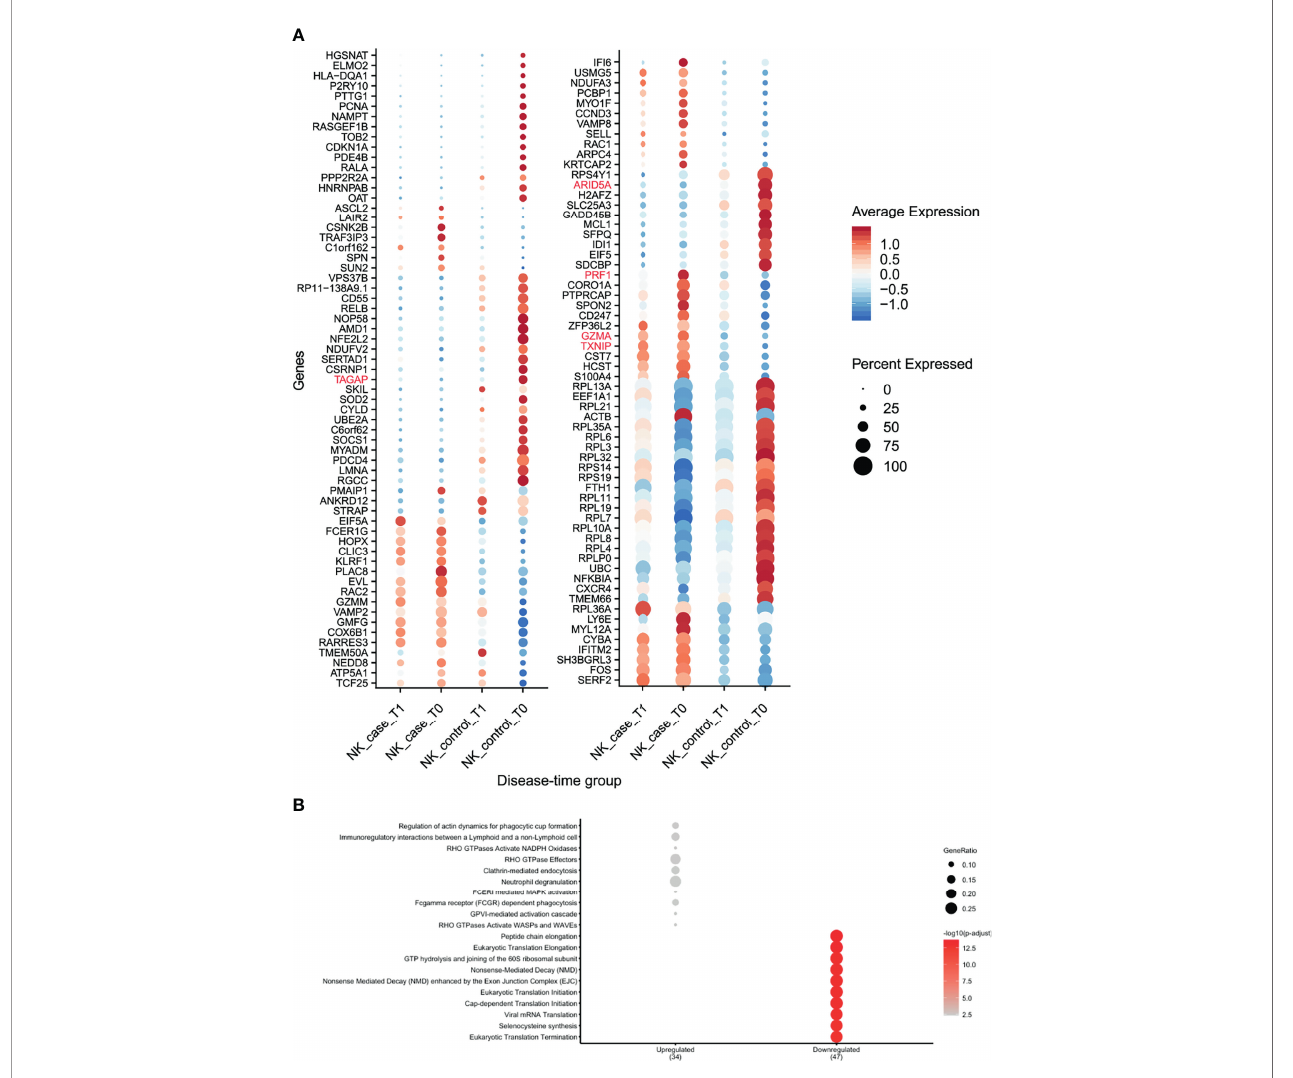
FIGURE 5 | NK cells showed several differences in gene expression before seroconversion of CeD. (A) Dotplot shows the expression of DEGs classi fi ed as pre- diagnosis markers for NK cells. The average normalized expression is used to show how strongly the genes are expressed compared with the other groups, while the size of the dot indicates the percentage of cells within the cell type expressing that marker. Vertical axis shows the name of the genes, where red color is used for the top 5 DEGs. Horizontal axis indicates the condition and timepoint. (B) Pathway enrichment analysis for the pre-diagnosis markers in NK cells (similar to Figure 3